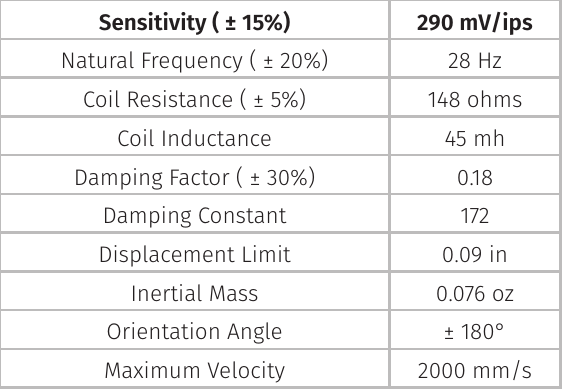
Figure 2. Geophone used in the fi eld test. Table I. Geophones technical specifi